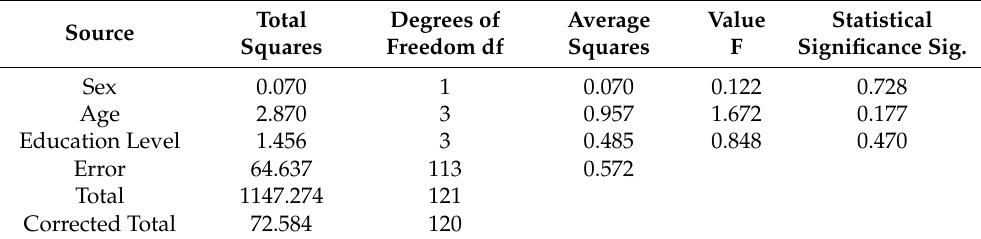
by volunteers due to gender, age, and educational